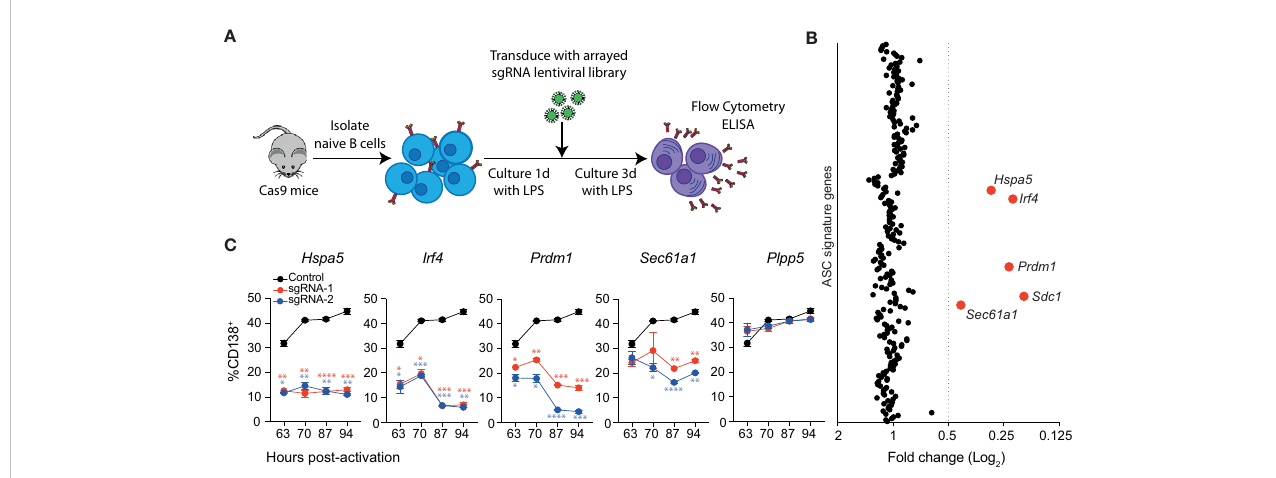
FIGURE 1 Identi fi cation of genes essential for LPS driven B cell differentiation in vitro. (A) Work fl ow of targeted CRISPR screen. Naïve splenic B cells were isolated from Cas9 expressing transgenic mice, activated with LPS and transduced with an arrayed lentiviral library that co-expressed speci fi c sgRNAs and BFP. Three days after transduction, cells were analyzed by fl ow cytometry and culture supernatant by ELISA. (B) Average fold changes in the proportion of transduced cells (BFP + ) that express CD138 for each targeted gene relative to the untransduced control. Genes with a fold change ≤ 0.5 are labelled and highlighted in red. Data points represent the mean of 2 independent sgRNAs from 2 replicate experiments. (C) Proportion of CD138 + cells among cells transduced with sgRNAs (BFP + ) targeting Hspa5 , Irf4, Prdm1, Sec61a1 or the Plpp5 control at the indicated time post-activation with LPS. Data points represent the mean of triplicate wells and error bars indicate the S.E.M. *p < 0.05, **p < 0.01, ***p < 0.001, ****p < 0.0001. Data in (C) is representative of 3 independent